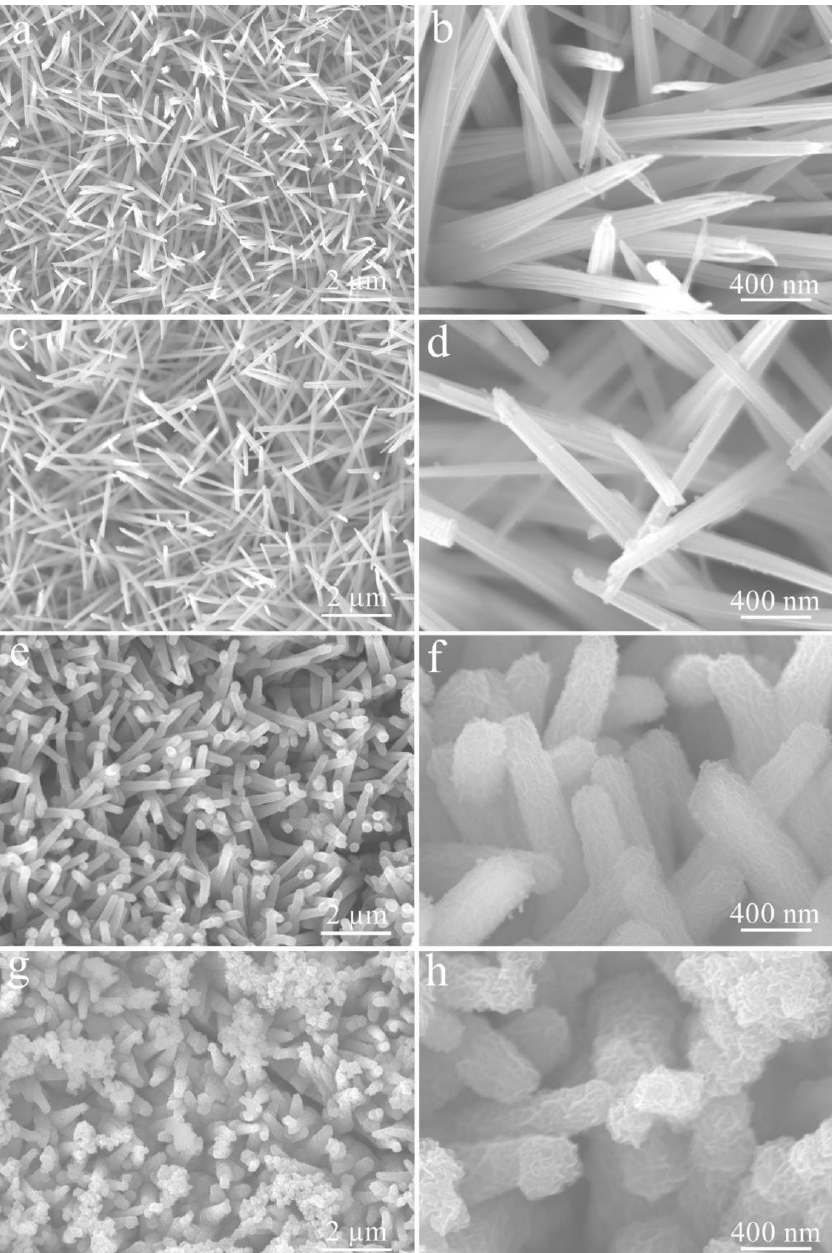
Figure 7. FE-SEM images of the Cu(OH) 2 /Ni 3 S 2 composite grown on copper foam with different potentiostatic deposition times of Ni 3 S 2 : ( a , b ) S-1; ( c , d ) S-10; ( e , f ) S-20; and ( g , h ) S-40.